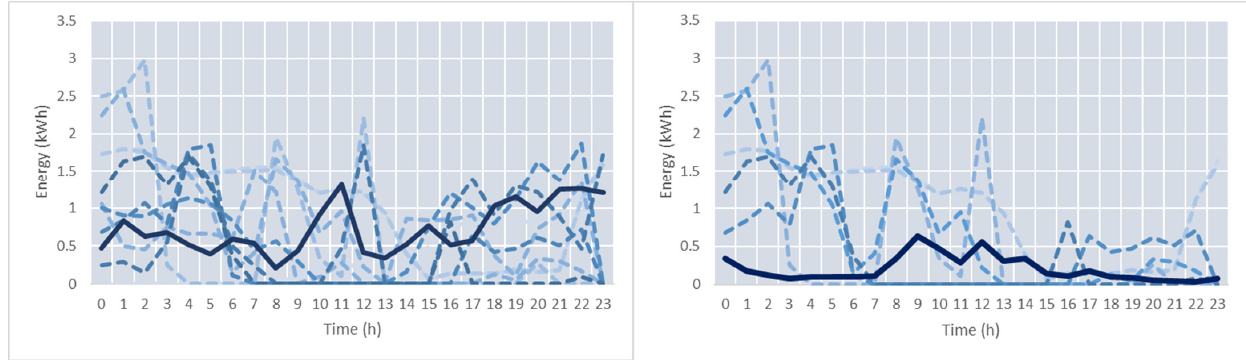
Figure 10. The energy profiles from clusters with id 6 (energy peaks— left ) and label 3 (energy valley— right ). The dashed curves are the energy profiles belonging to the cluster, and the straight line is the cluster center.